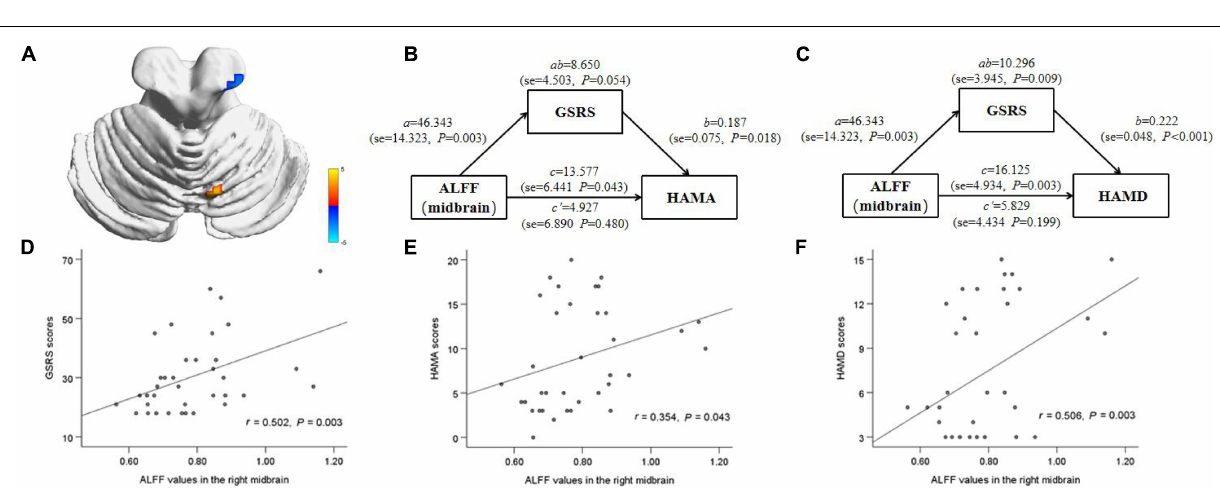
FIGURE 3 | Comparing to HCs, IBS-D patients showed enhanced connectivity between the seed region in the left precuneus and the bilateral orbital frontal cortex (TFCE, FWE-corrected P < 0.05) (A) . Distribution of FC values between left precuneus and right OFC (B) /left OFC (C) in the two groups and differences between groups. L, left; R, right; FC, functional connectivity; OFC, orbital frontal cortex; IBS-D, diarrhea-predominant irritable bowel syndrome; HC, healthy controls.